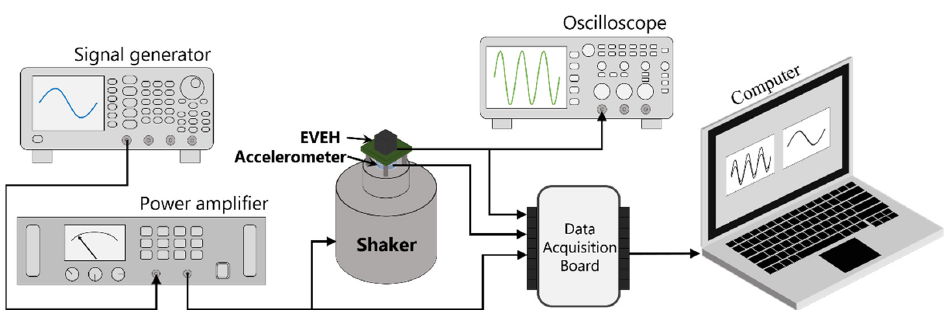
Figure 6. Schematic illustration of the measurement